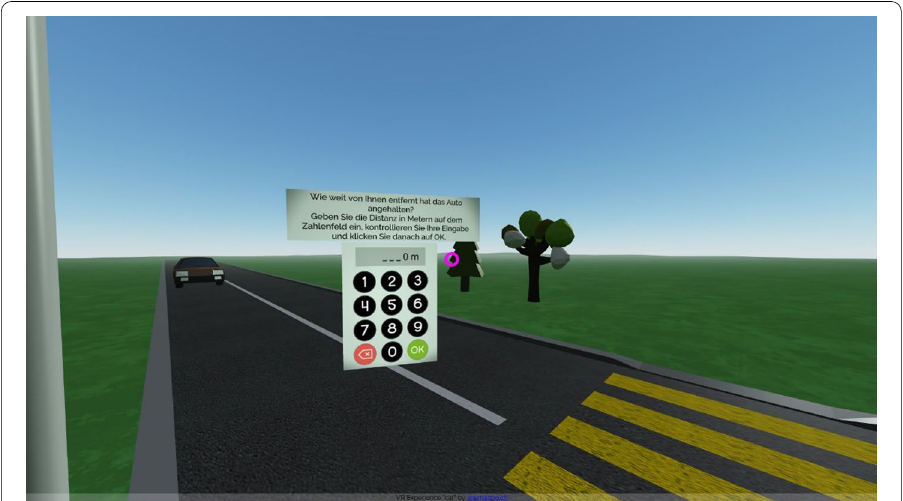
Fig. 4 View of the mobile VR distance perception module where students had to estimate their distance to the car. Different light (day/night) and headlight (on/off) conditions were used. The picture above shows the day condition with clear